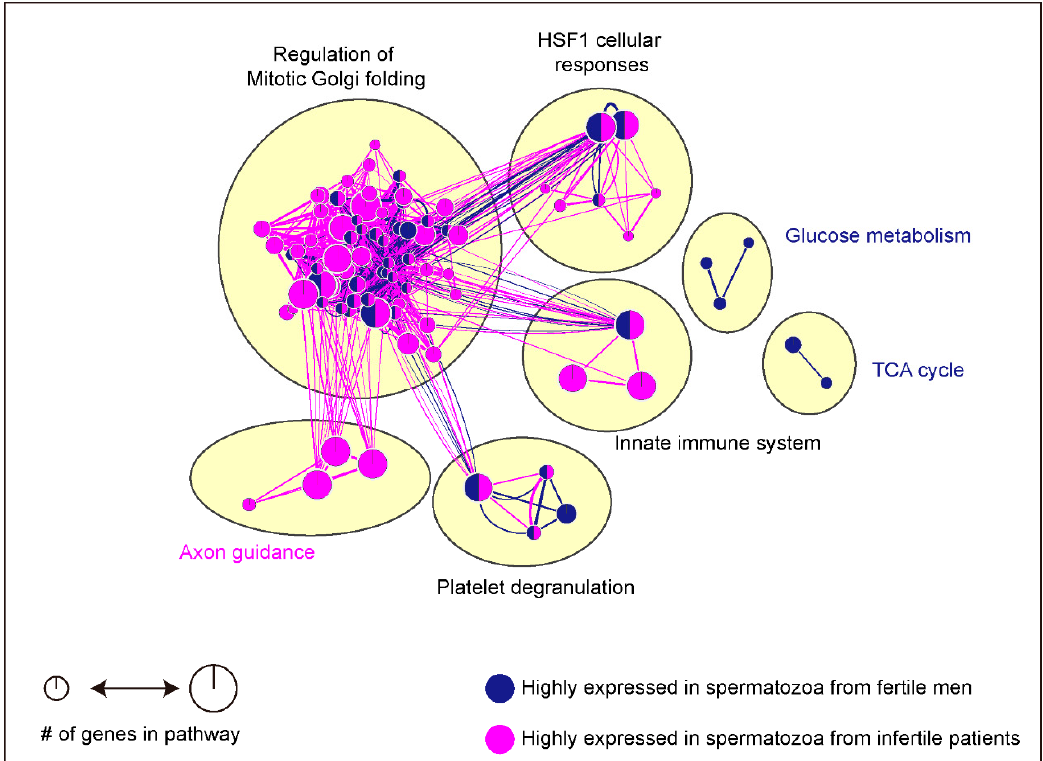
Figure 4. Signaling pathways according to differentially expressed genes between fertile and infertile human spermatozoa. Signaling pathways based on the differentially expressed proteins in spermatozoa from fertile and infertile men were determined using g: Profiler, Cytoscape, and EnrichmentMap. Blue represents enrichment in spermatozoa from fertile men, while purple represents enrichment in spermatozoa from infertile patients. Node size indicated how many genes are involved with pathways.